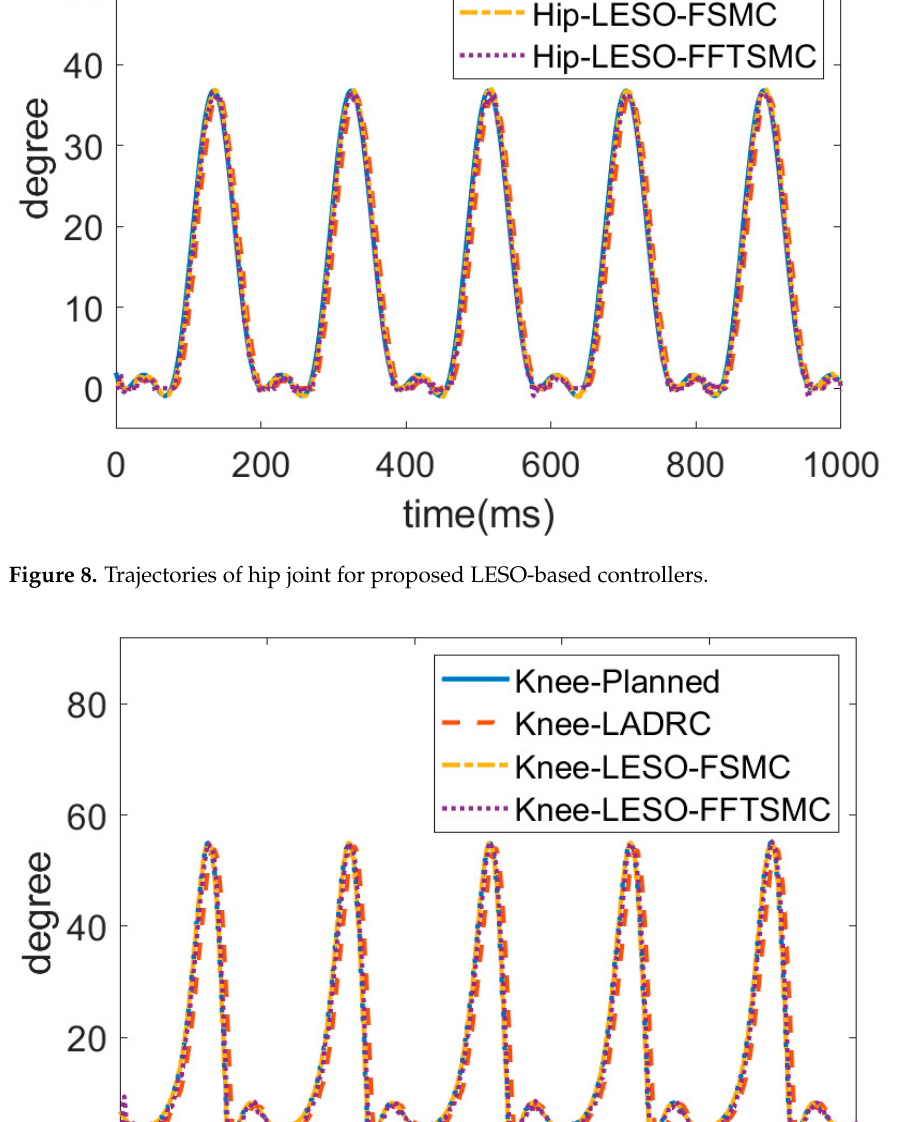
Figure 7. Walking experiments for gait training with robotic hip-knee exoskeleton.